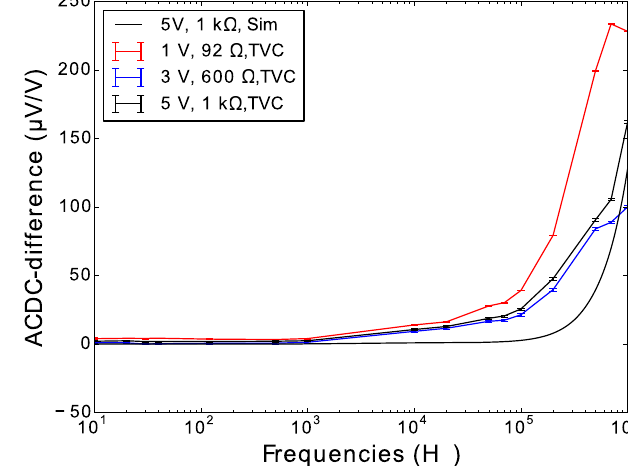
Fig. 7. Resulting ac – dc difference for the buffer from 10 Hz up to 1MHz. The red curve contains the measurements for 1V, the blue curve contains the measurements for 3V, and the black curve contains the measurements for 5V. The equivalent simulation of applied 5V has been included in black, without error-bars.